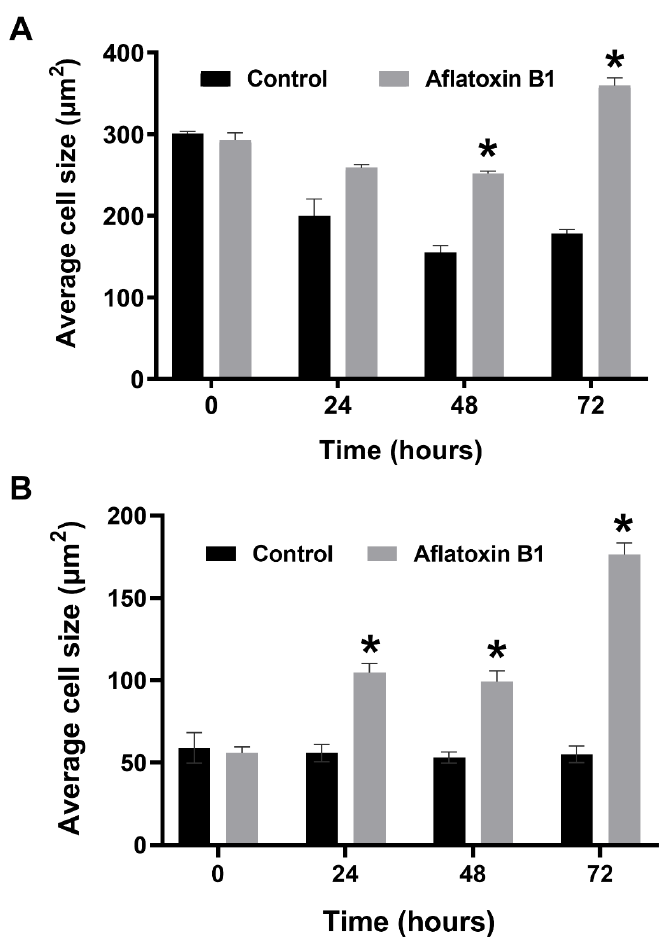
Figure 4. Cell size of MCF7 ( A ) and MCF10A ( B ) cells after treatment with aflatoxin B1. * p < 0.05 as compared to control.